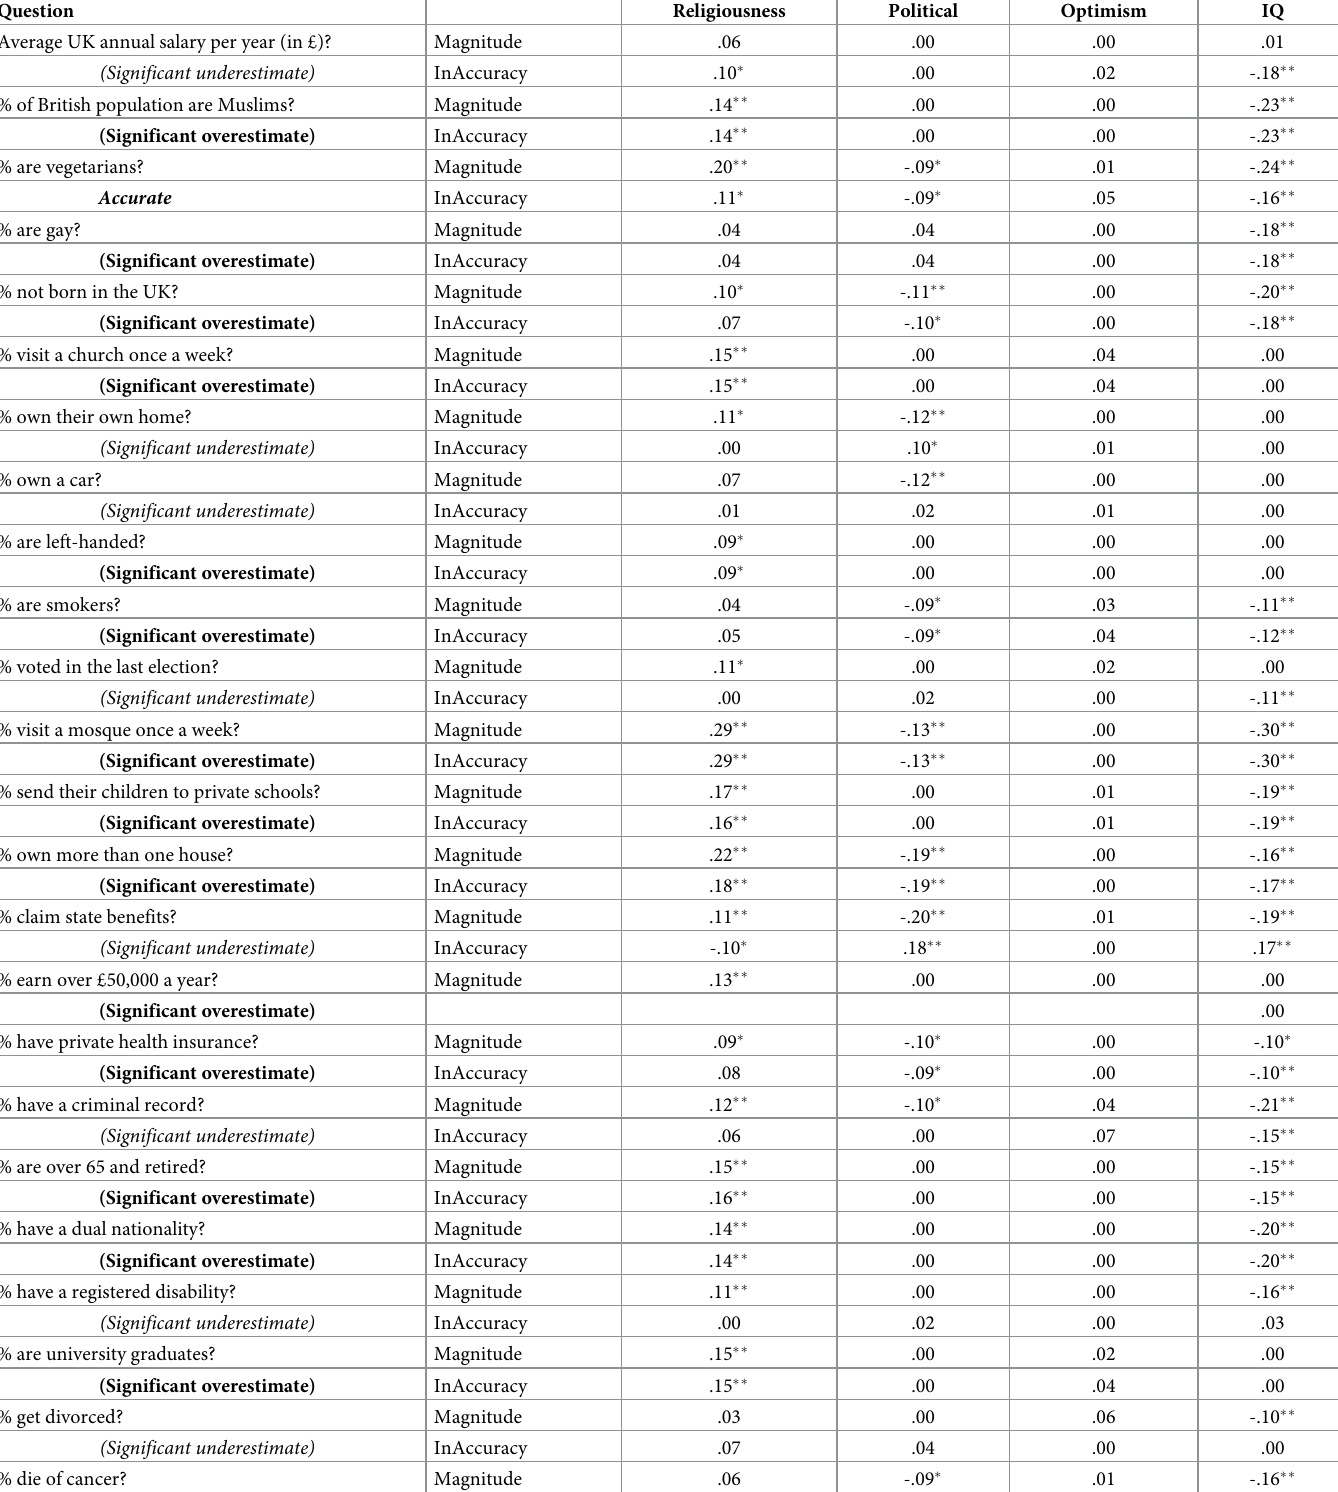
Table 3. Correlations between responses to the 25 questions, three attitudes and IQ–by magnitude and absolute